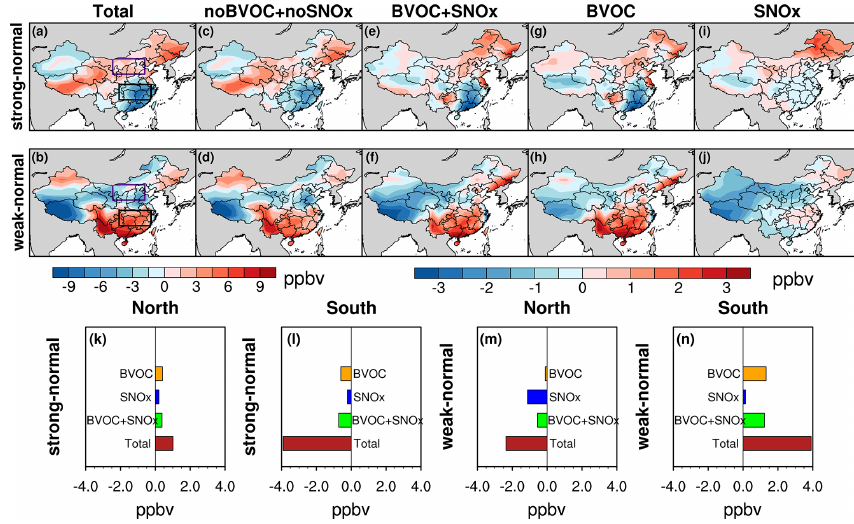
Figure 6. Panels (a) and (b) show the simulated difference in MDA8 (ppbv) of strong and weak WPSHs relative to normal WPSHs (same as Fig. 2a, b; filled contours). Panels (c) and (d) are the same as (a) and (b) except turning off MEGAN and soil NO x emissions. Panels (e) and (f) show the difference between simulations with MEGAN and soil NO x emissions on (a, b) and off (c, d) , which represents the contribution of BVOCs and soil NO x . Panels (g) and (h) show the difference between simulations with MEGAN emissions turned on and off, which represents the contribution of BVOC emissions. Panels (i) and (j) show the difference between simulations with soil NO x emissions turned on and off, which represents the contribution of soil NO x emissions. Note that (a) – (d) use the left color bar and (e) – (j) use the right color bar. (k–n) The contribution of BVOC, soil NO x (SNO x ), and BVOC with soil NO x (BVOC + SNO x ) for a northern (36.0–2.0 ◦ N, 105.0–117.5 ◦ E) and southern (26.0–32.0 ◦ N, 107.5–120.0 ◦ E) region (purple and black boxes in a and b